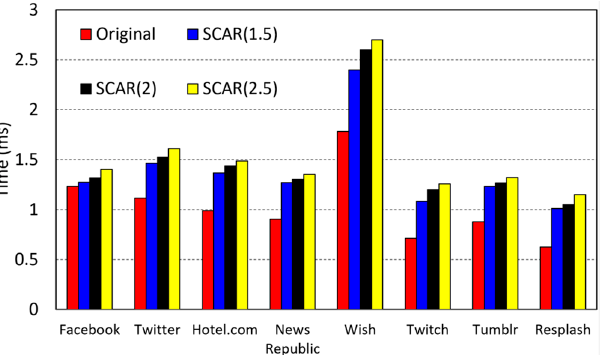
Figure 12. Execution time of the method PerformTraversals() of class ViewRootImpl.